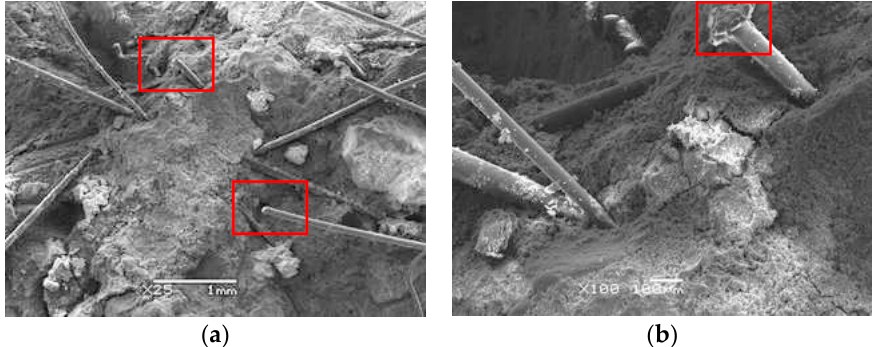
Figure 21. Interface between mortar and detritus: ( a ) w/c ratio: 0.68; ( b ) w/c ratio: 0.54; ( c ) w/c ratio: 0.44.